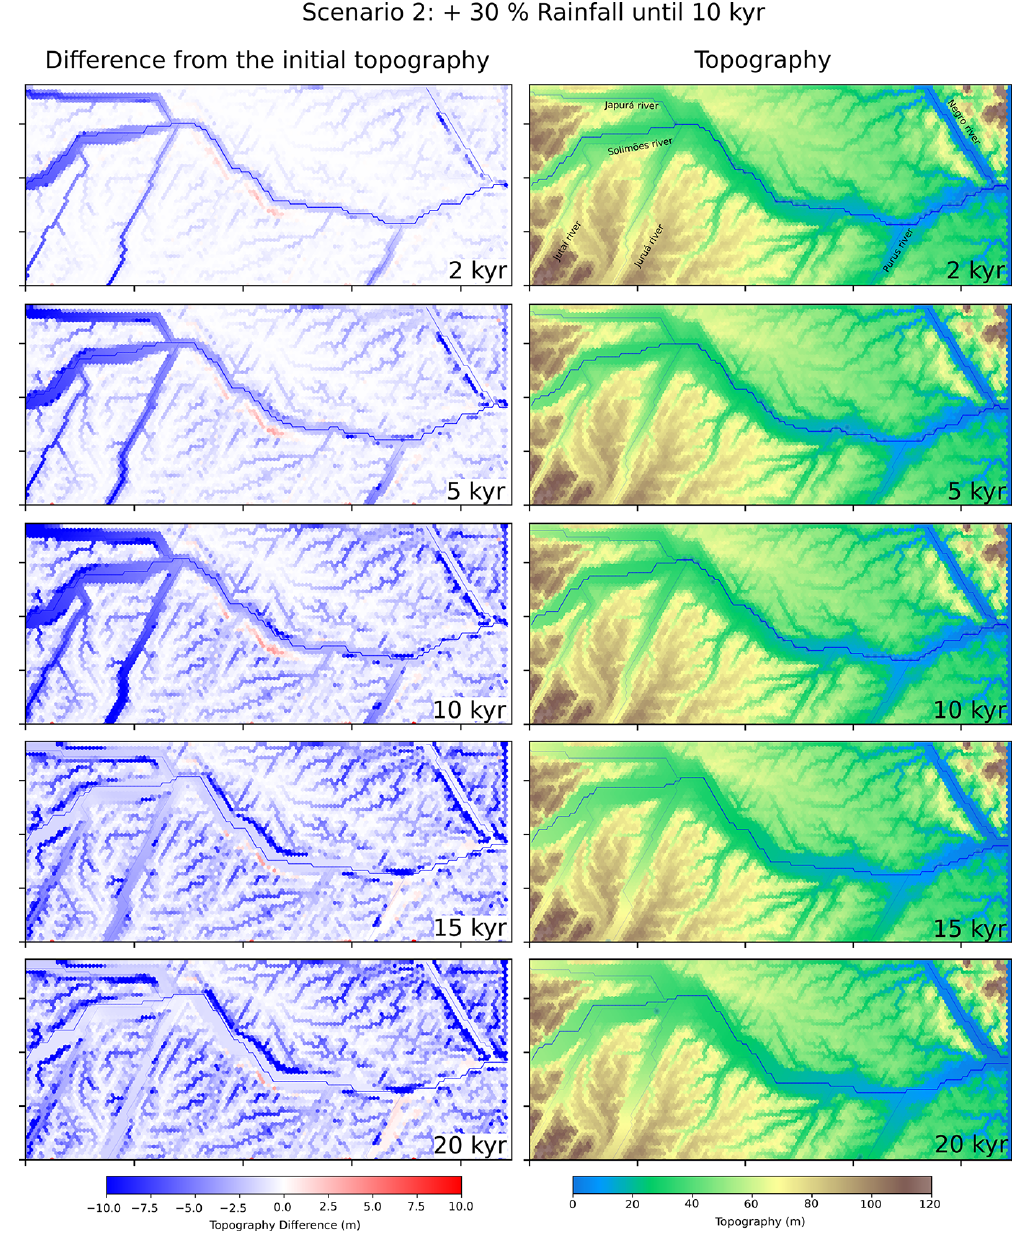
Figure 5. Results of the landscape evolution of scenario 2. The left figures show the difference of the model topography in relation to the initial topography, with colors saturated in red for values in elevation differences higher than 10m and in blue for values below − 10m. The right column shows the topography itself. The occasional blue stains on the map represent lakes (local